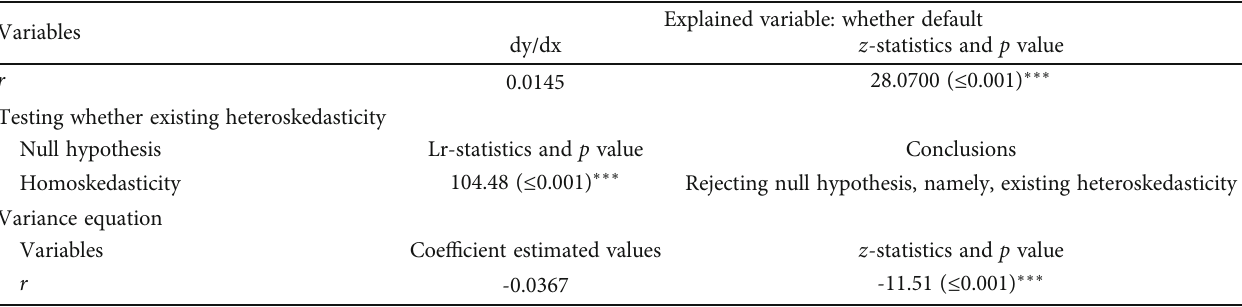
Table 2: Single factor estimated results of heteroskedasticity Probit model of